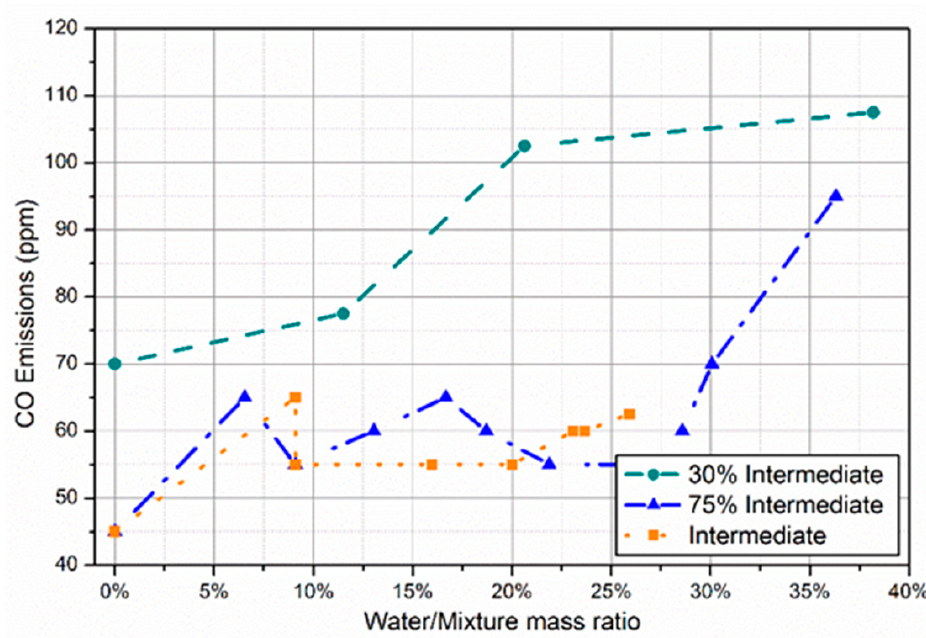
Figure 7. Influence of percentage of water content (by mass) in the mixture on CO emissions.